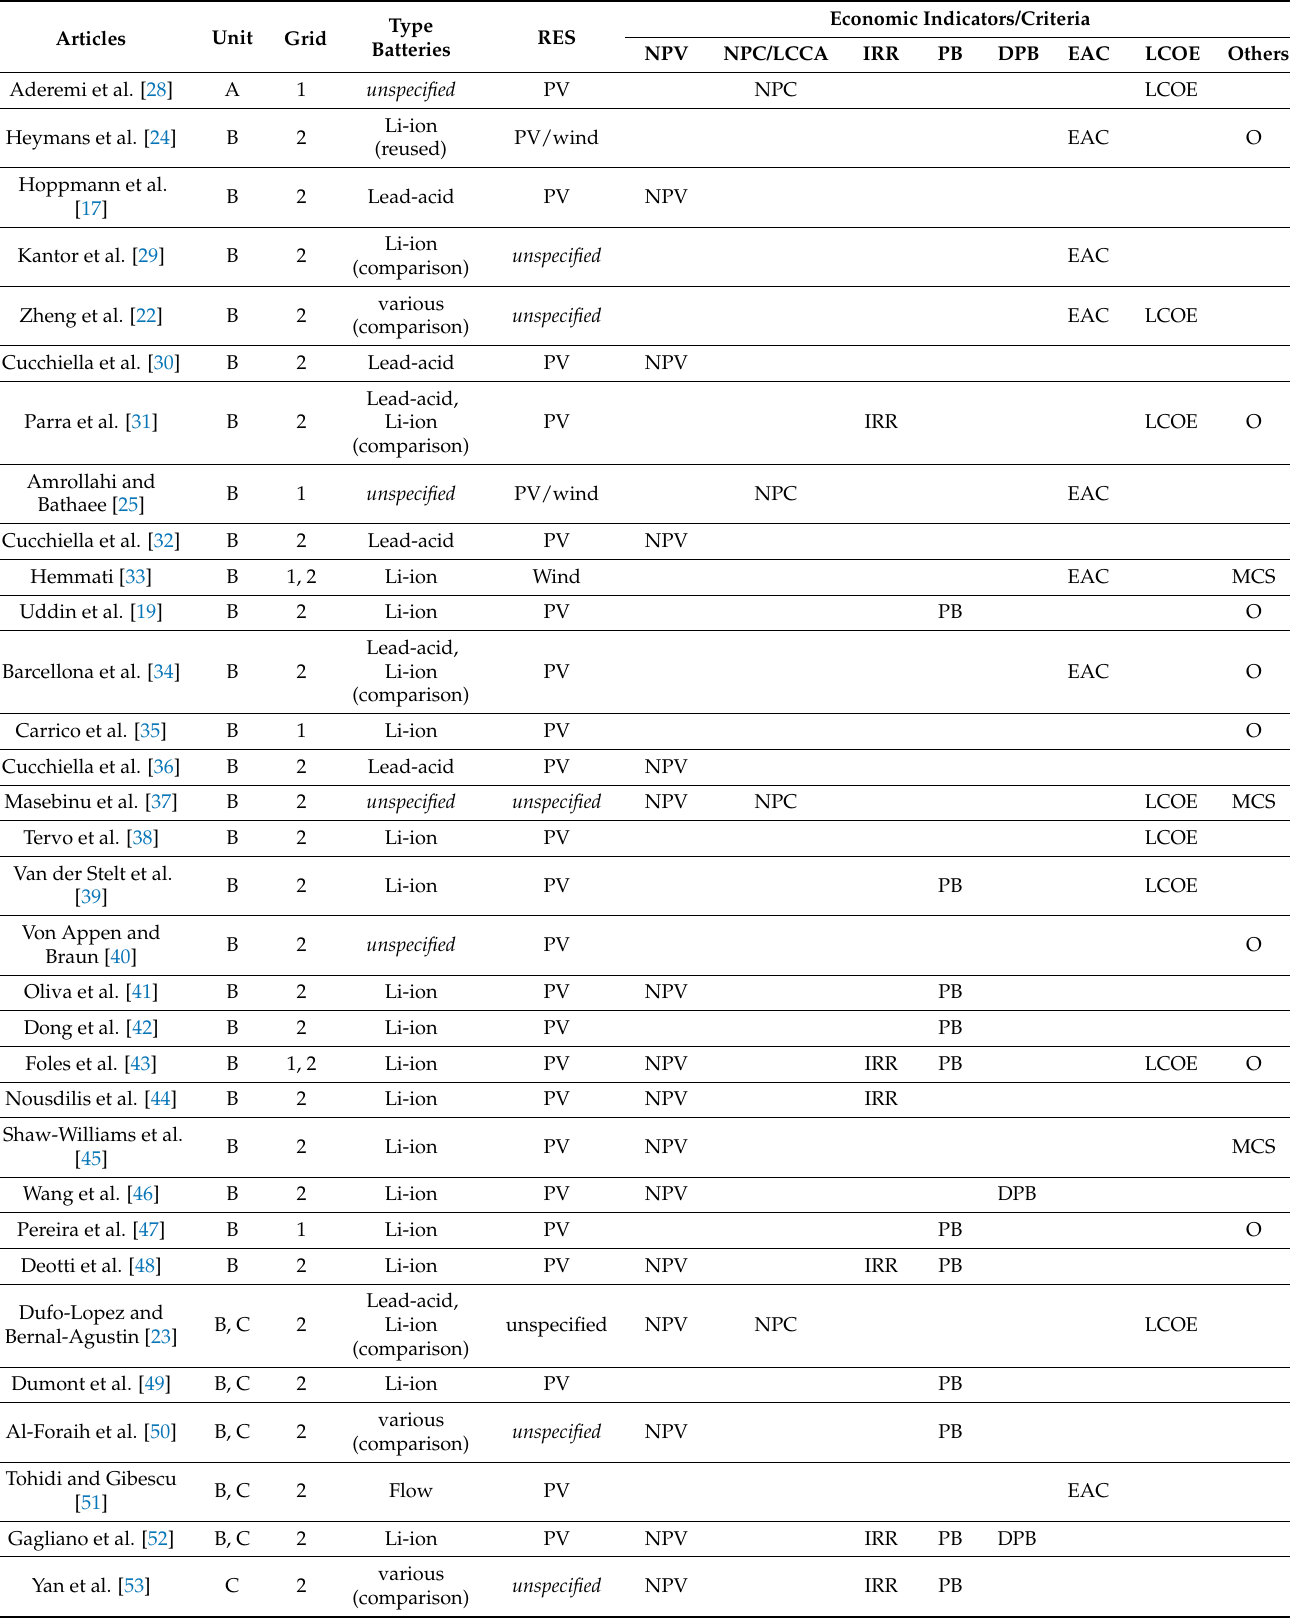
Table 2. Summary table of technologies, sources, and approaches used in the feasibility